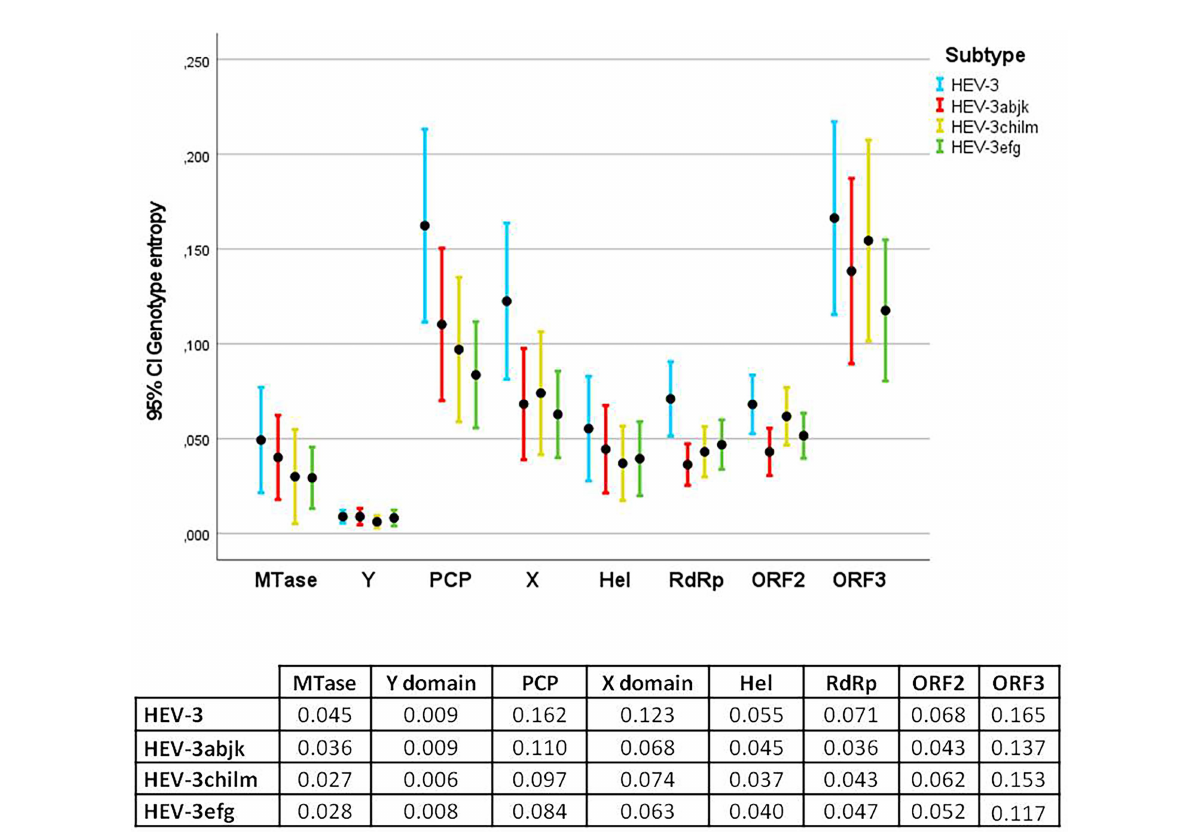
FIGURE 1 Error bar graph showing the mean entropy and 95% confidence interval (CI) for each protein in HEV-3, HEV-3abjk, HEV-3chilm, and HEV-3efg. The table below shows the average entropies of each protein. PCP and ORF3 exhibited statistically significant differences compared with MTase, Y domain, Hel, RdRp, and